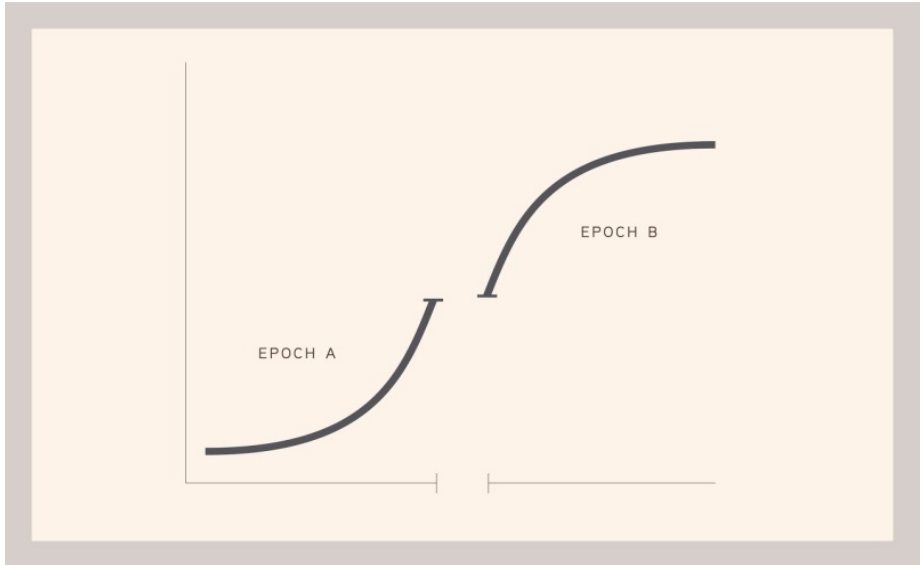
Figure 4. Phases of changing world population: An upward facing, accelerating curve Jonas Salk called Epoch A and a downward facing, decelerating curve, called Epoch B. To someone born in Epoch A, the future would appear to have few limitations in terms of growth, resources, and available energy. Someone living in Epoch B would however, have a distinct sense of limitations and the necessity to adapt to the approaching of a plateau in population growth. The di ff erence in the shape of the curves implies that there will be fundamental qualitative di ff erences in the nature of human life between the two Epochs.